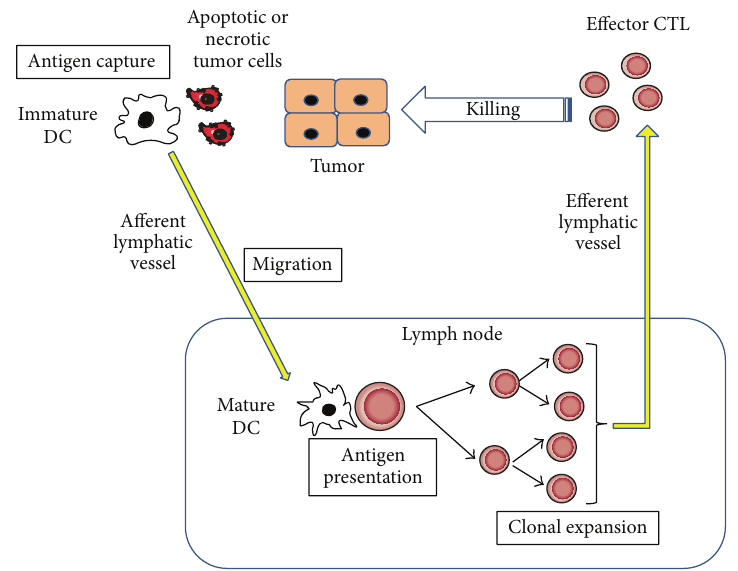
Figure 6: Tumor immunity generation